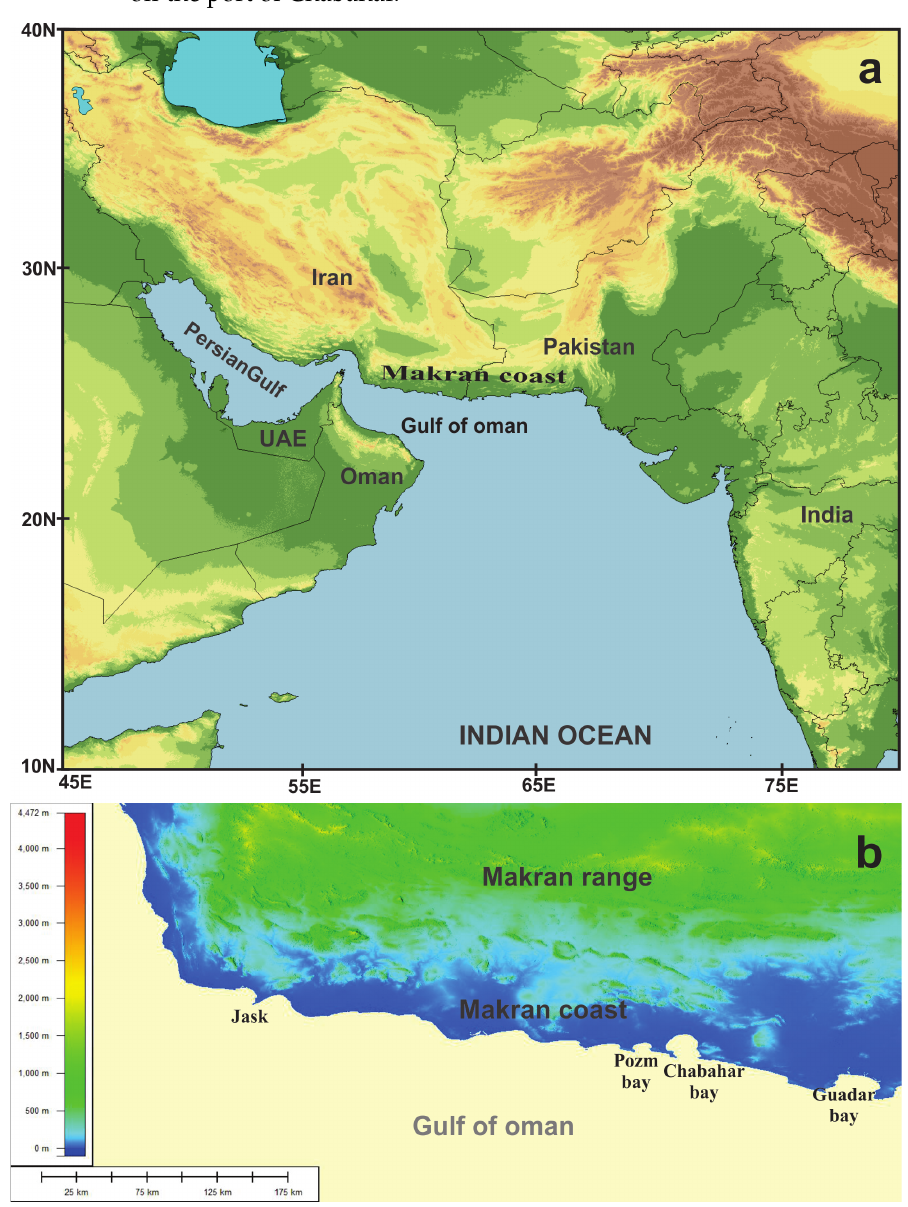
Figure 1. Location map of the Makran coast in the northwestern Indian Ocean ( a ) SRTM-DEM of the Iranian coast of Makran ( b